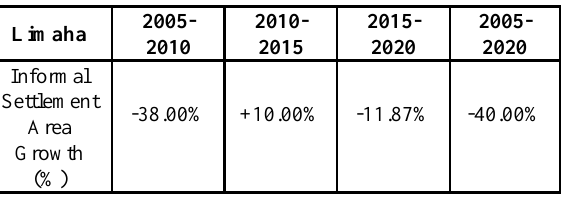
Table 3. Informal Settlement Growth in Percentage